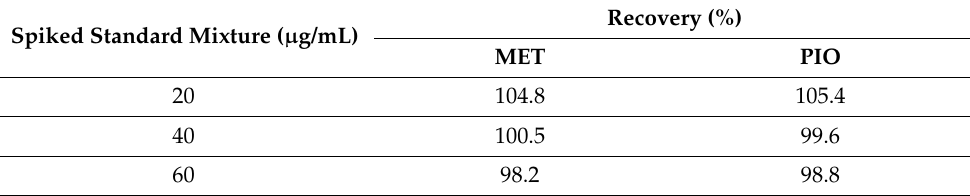
Table 2. Recoveries obtained from the determination of MET and PIO in commercial formulations that contain different levels of spiked